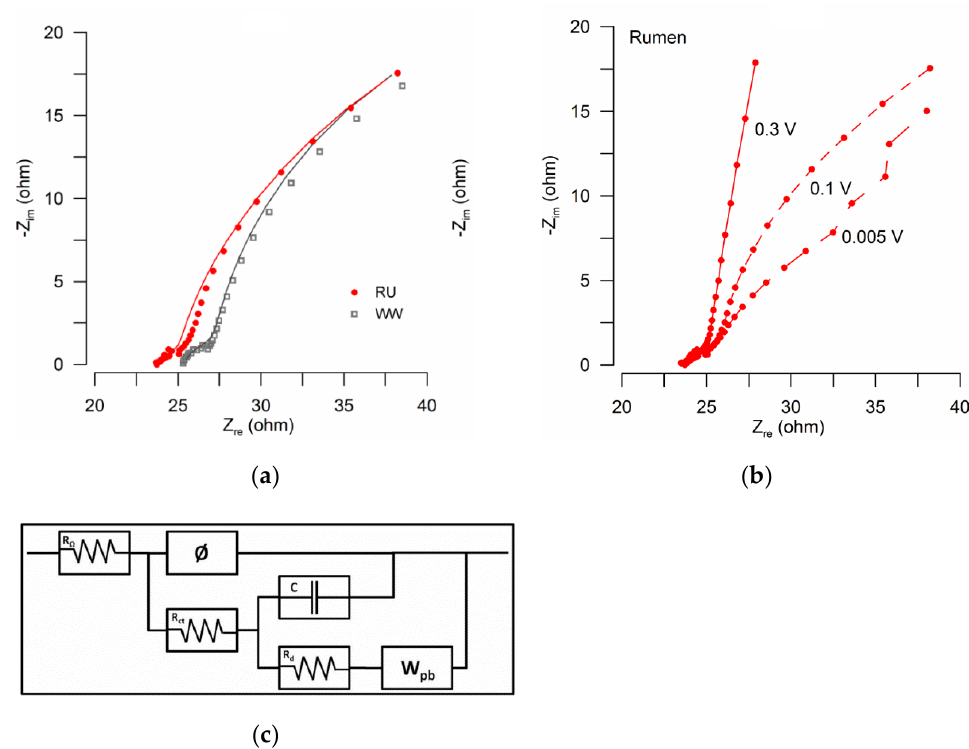
Figure 6. EIS of cathodes. ( a ) Nyquist plot of cathodes tested at 0.1 V. Experimental data (dots) and equivalent circuit model (lines). RU: rumen plus wastewater; WW: wastewater. ( b ) Nyquist plot of rumen reactor cathode poised at different potentials to show the dominance of Rd in the impedance. ( c ) The equivalent circuit was used to fit experimental data. Ohmic resistance (RΩ); Charge transfer resistance (Rct); Diffusion resistance (Rd); Constant phase element (Ø); Capacitor (C); and Porous bounded Warburg element (Wpb). Table 2. Values of ohmic (R ohm ), charge transfer (R ct ), and diffusion (R d ) resistance calculated by fitting experimental data with an equivalent circuit using χ 2 -minimization.